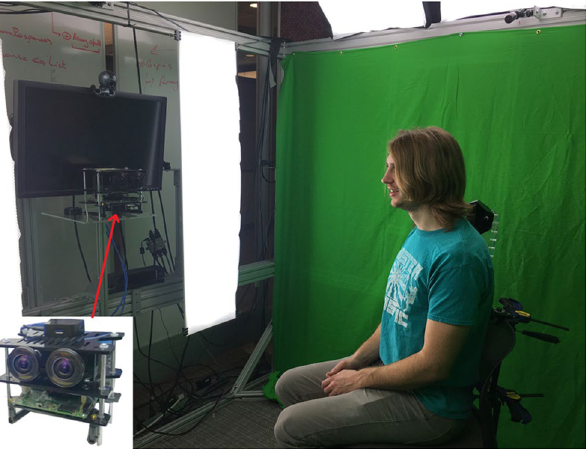
Figure 3. Stimuli recording setup. Recording setup with the stereoscopic camera and the actor sitting ready to record the corpus.